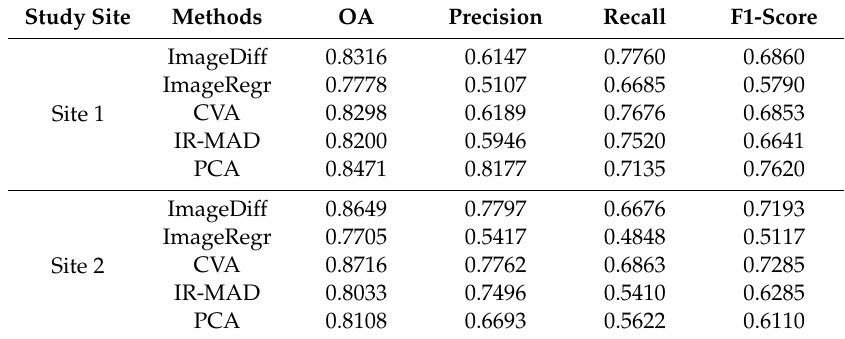
Table 1. Accuracy of the CD maps generated using various pixel-based unsupervised CD methods. Study Site